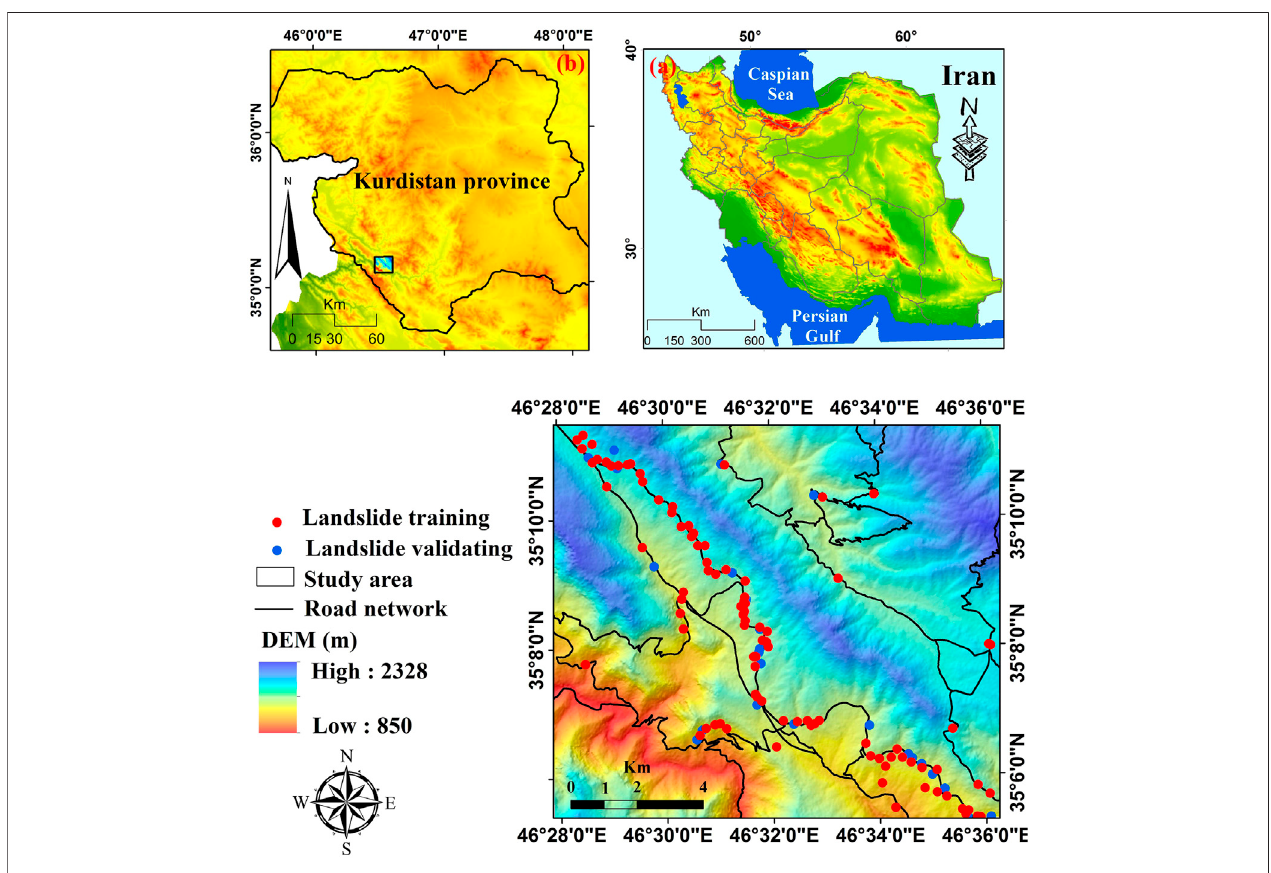
FIGURE 1 | Study area location in (A) Iran and (B) Kurdistan